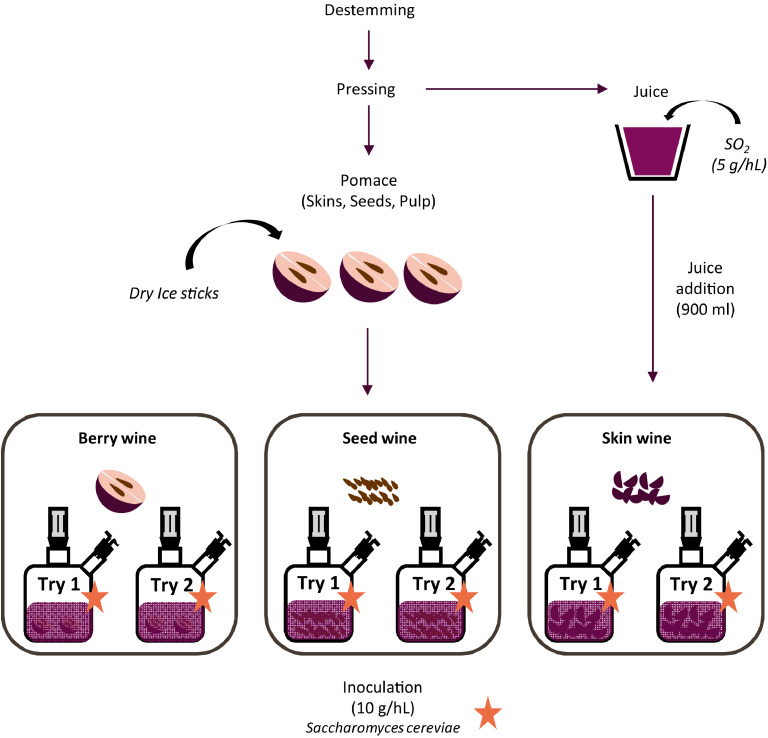
Winemaking method.